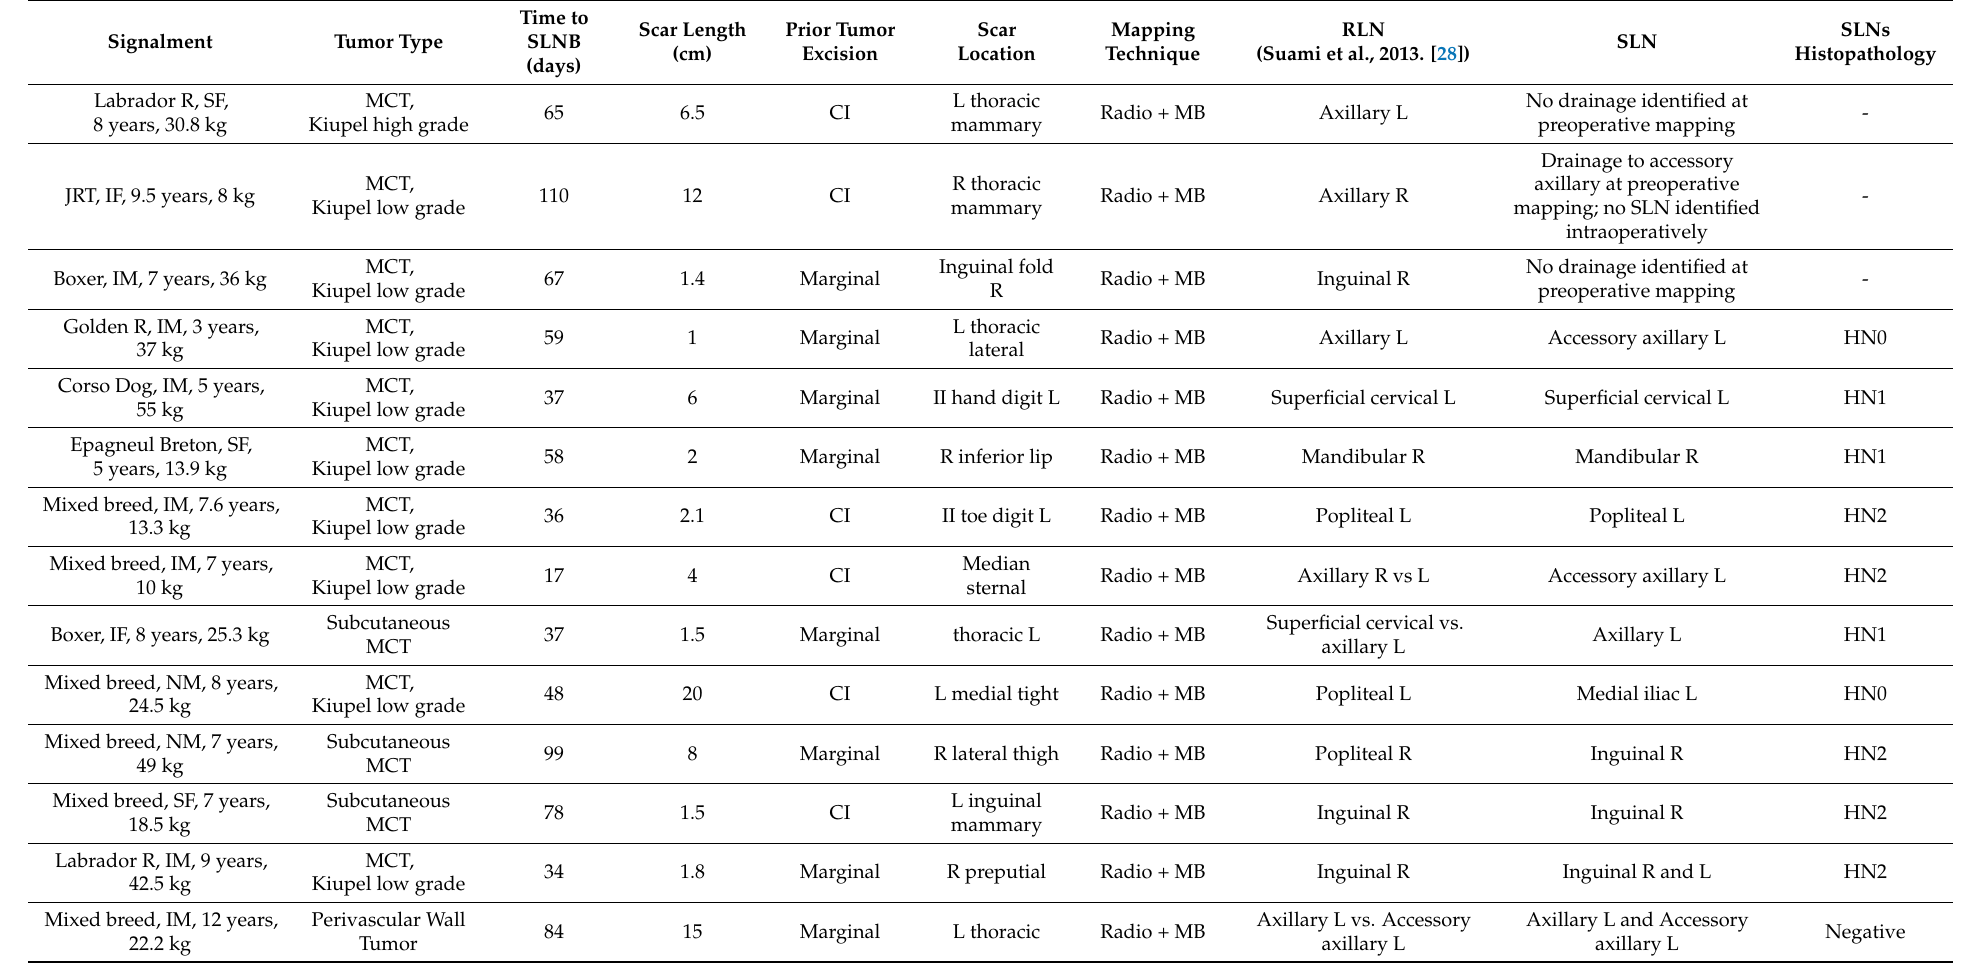
Table 1. Signalment, histopathological data of excised tumors and SLN, and clinical characteristics of the scars, as well as of SLN mapping and extirpation in the study